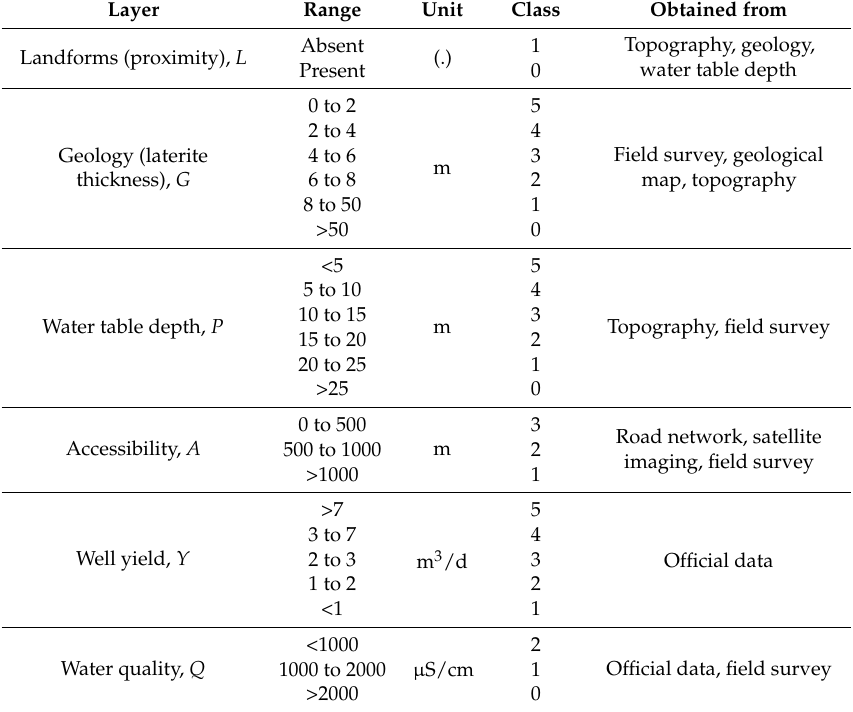
Table 3. Main features of the spatial database, including classification values for feasibility